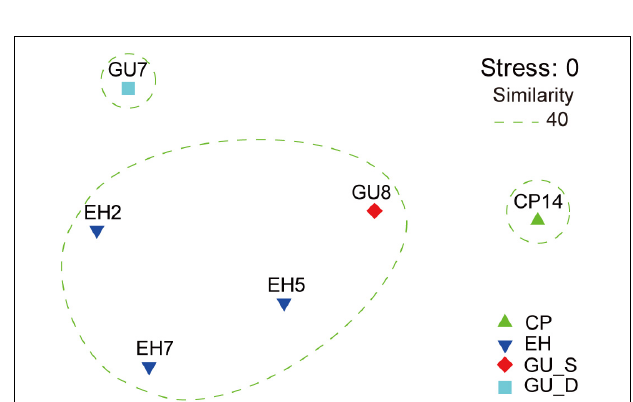
FIGURE 2 | Bacterial composition distributions at the phylum level across all samples in the Union Glacier area. Sequences were assigned in the RDP reference database by using a 80% confidence cut-off.